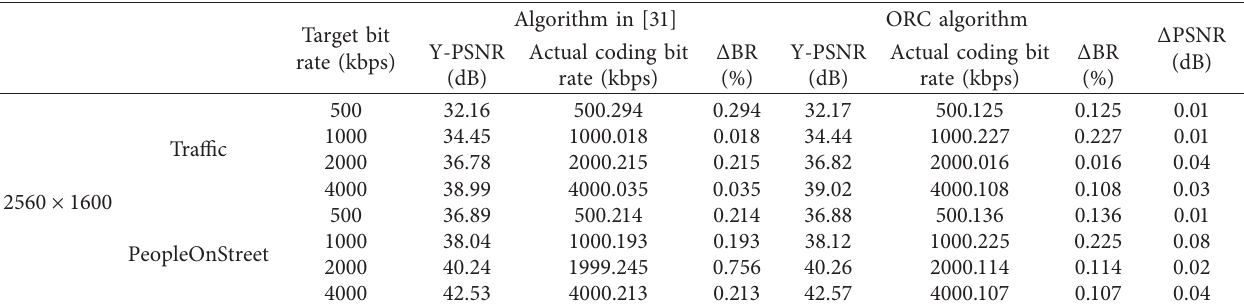
Table 3: Experimental comparison data between the ORC algorithm and algorithm in